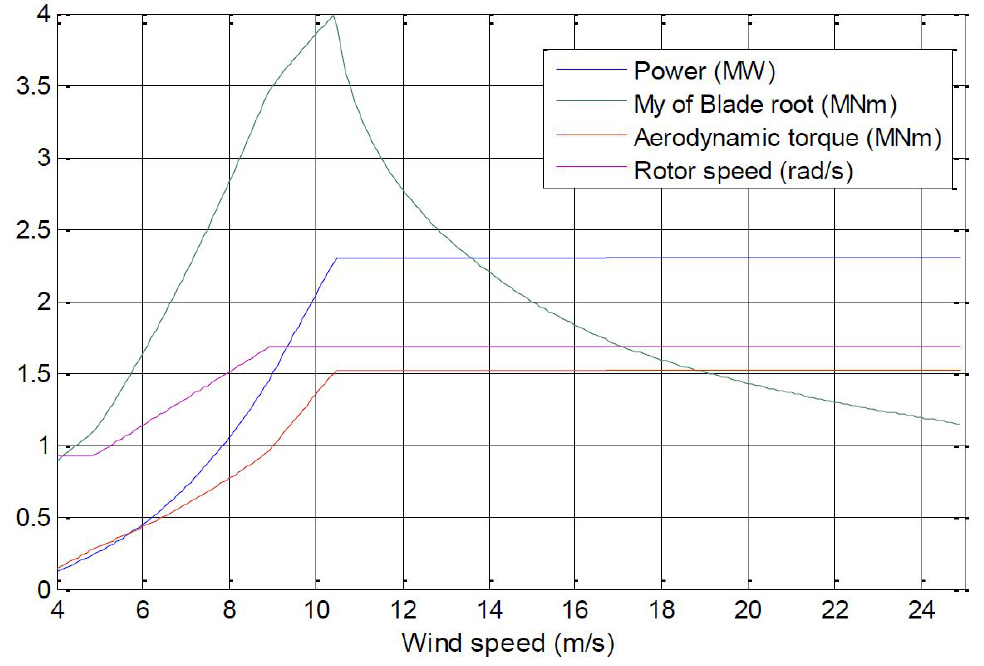
Figure A1. Variation of general parameters of wind turbine’s base model as a function of mean wind speed in steady-state conditions